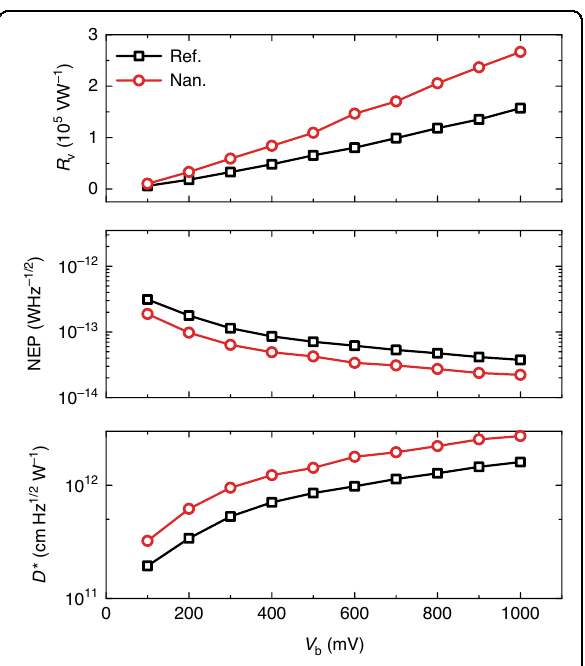
Fig. 3 Performance vs. bias. R v , NEP, and D * of the devices at different voltage bias for room temperature operation at 0.171